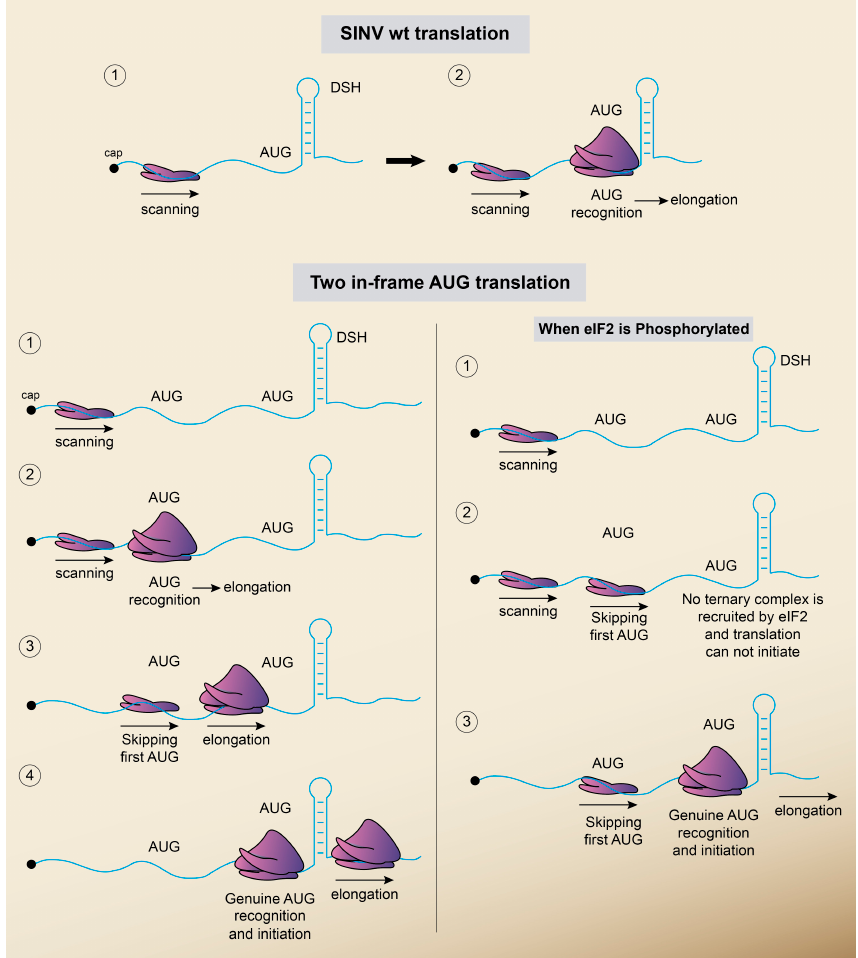
Figure 5. Schematic representation of the model for the initiation of translation on SINV sgRNA. (Upper panel) In the model of the scanning mechanism followed by WT SINV sgRNA to initiate translation, the 40S ribosomal subunit attaches initially at the 5 ′ cap structure. Then, the 5 ′ UTR is scanned base-by-base in a 5 ′ –3 ′ direction until the initiation codon (AUG) is recognized. (Lower panel) Model for translation initiation on SINV sgRNA bearing two alternative start codons (AUG). Under no stress conditions (left part), the preinitiation complex containing the 40S ribosomal subunit interacts with the cap structure and scans the leader sequence of sgRNA until the first AUG is encountered. Then, the 80S initiation complex can be formed and elongation ensues. Another preinitiation complexes can start scanning from the cap structure and, in some cases, skip the first AUG start codon and reach the second AUG (genuine AUG), initiating the synthesis of authentic C protein from this start codon. When eIF2 is phosphorylated (right part), the lack of functional eIF2 prevents the initiation in the first AUG, nevertheless the genuine AUG, which is in proximity with DSH, manages to initiate the translation independently of the